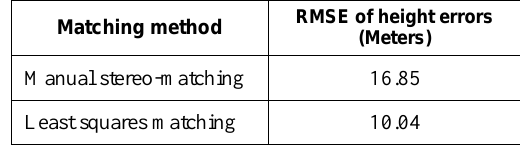
Table 2. Effect of VCPs position improvement using